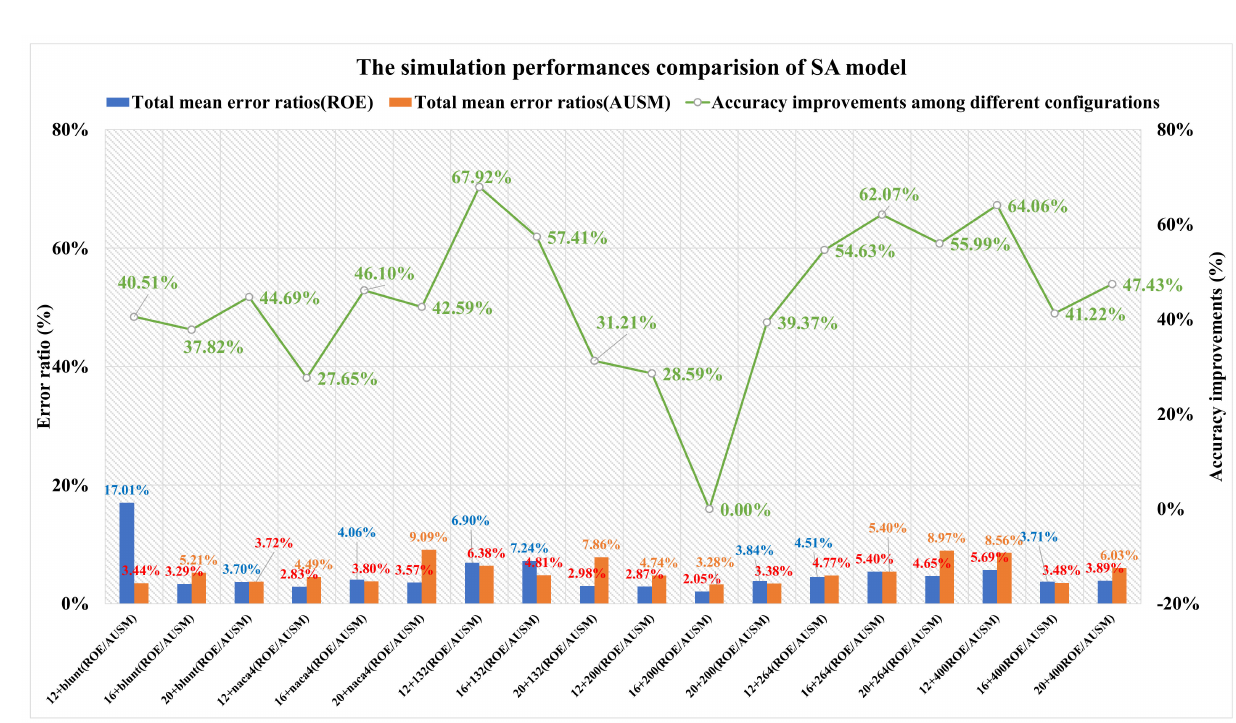
Figure 32. Comparison of the simulation performances of SA turbulence model under different sim-ulation